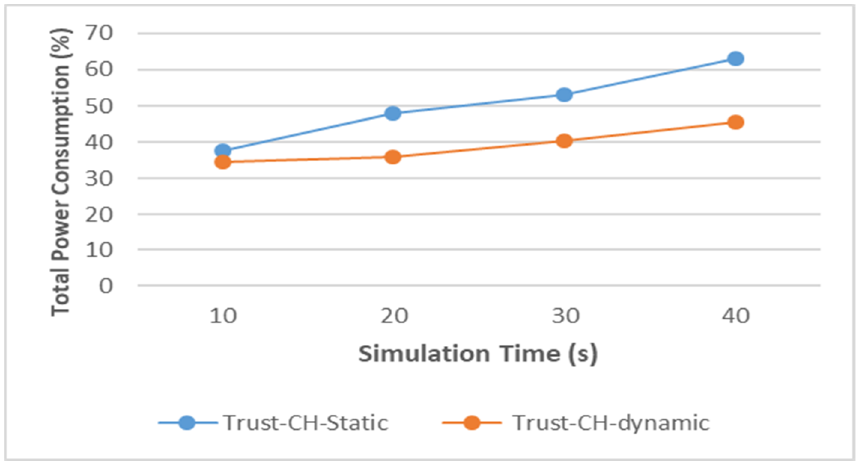
Figure 8. The Trust-CH power consumption analysis.